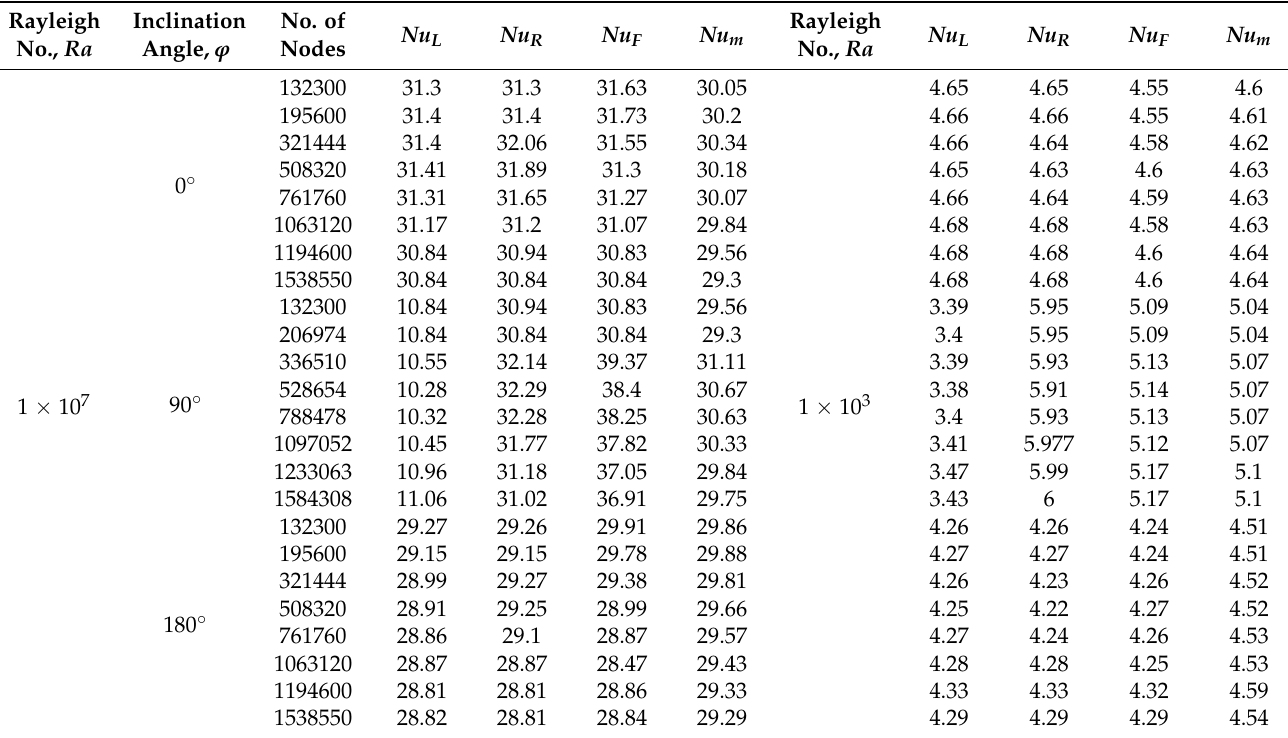
Table 1. Results of grid independent study.